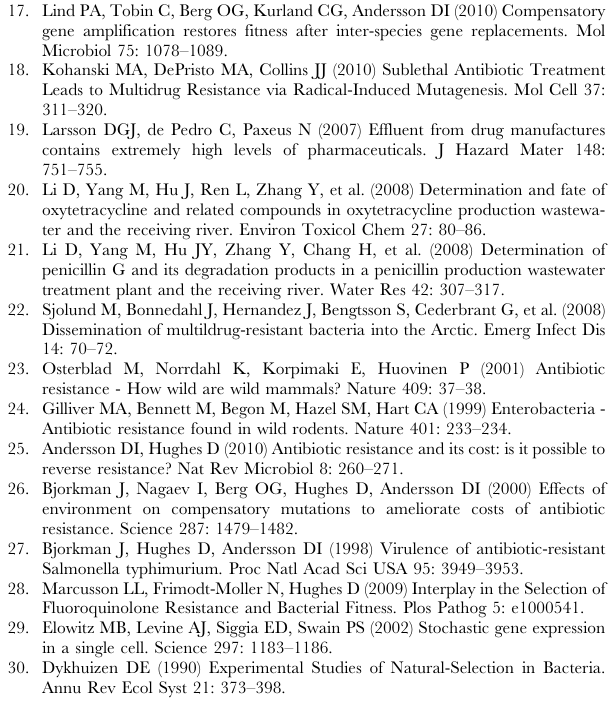
Figure S1 Competition experiments between two wild type S typhimurium strains marked with either yfp or cfp (strains DA15110 and DA15111, Table S1 in Text S1). Each line represents one experiment (averages of four competitions), and a total of four independent experiments were conducted. Figure S2 Selection of de novo resistant mutants at sub-inhibitory concentrations of antibiotics. A total of 20 independent lineages of E. coli MG1655 were serially passaged in Mueller-Hinton medium containing 2.3 ng/ml ciprofloxacin. Every 100 generations approximately 10 5 cells were plated onto LB agar containing